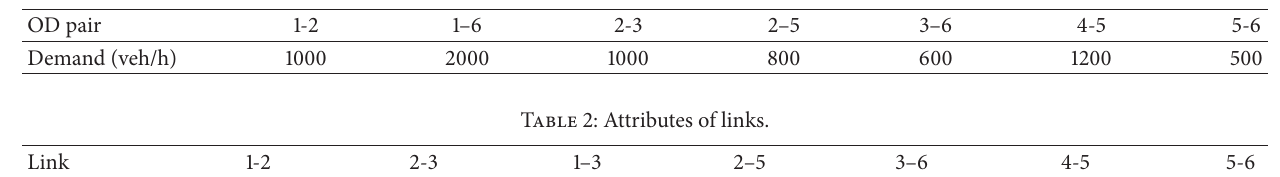
Table 1: OD demands.